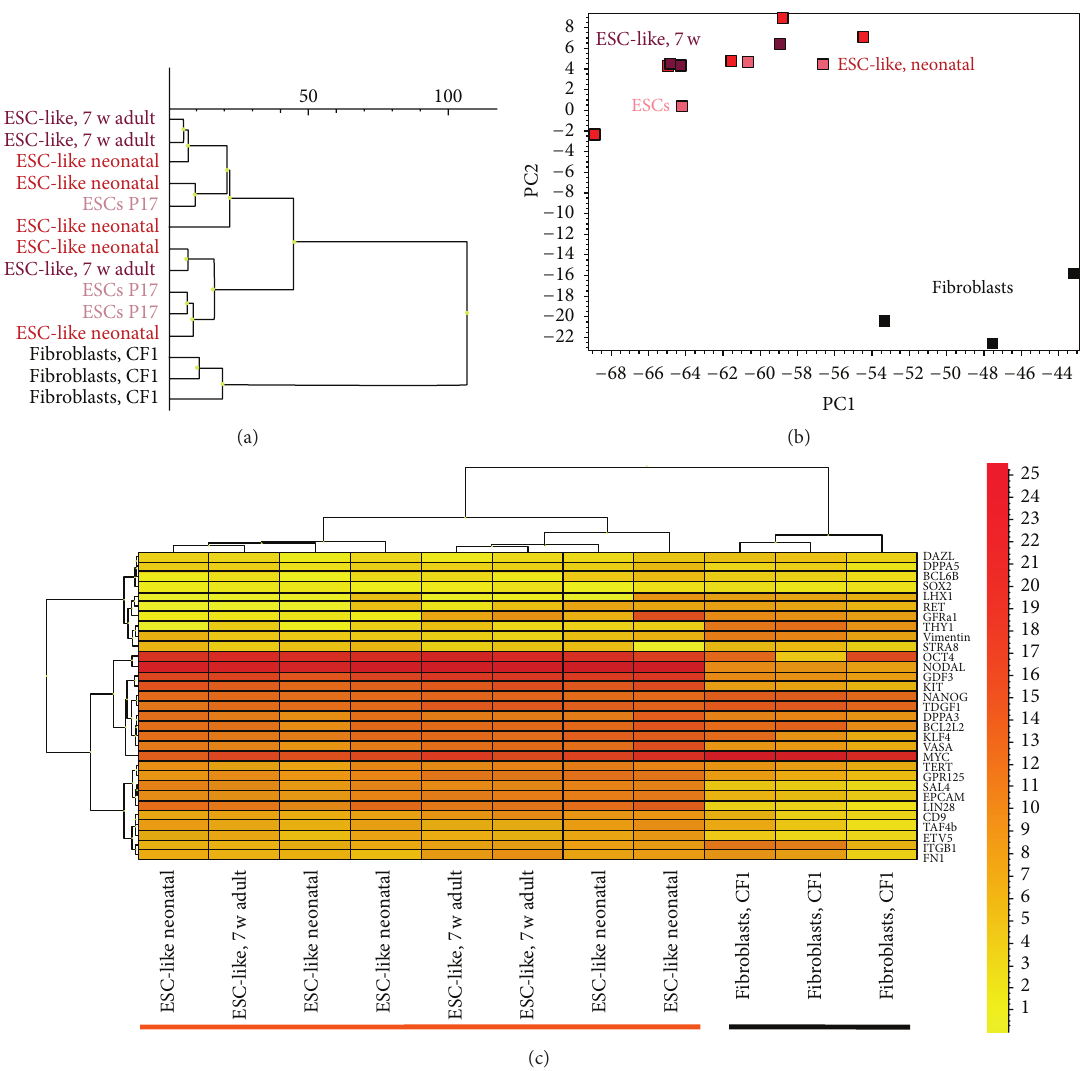
Figure 7: Similar gene expression profiles of ESC-like cells and mESCs with germ cell-enriched and pluripotency associated genes. (a) Dendrogram and (b) PCA clearly demonstrate that ESC-like cells and mESCs are similar to each other but distinct to fibroblasts which localize in separated trees or areas. (c) Heat map shows array of pluripotency and germ cell associated genes with a cluster of ESC-like cells and mESCs (both underlined with orange bar), while fibroblasts cluster in a separate tree (underlined with black